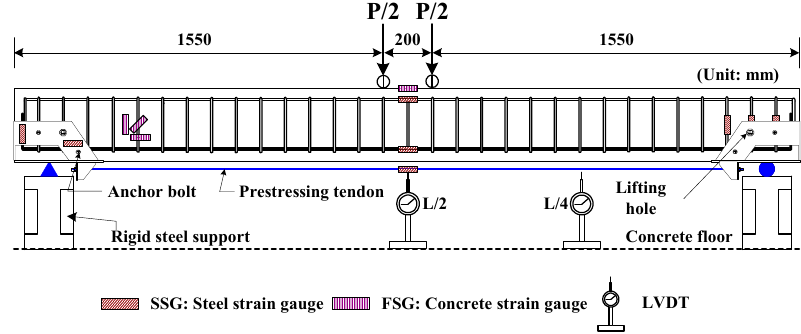
Figure 3. Test and measurement setups. P/2: half of the external total load; L/2: mid ‐ span; L/4: quarter ‐ span.